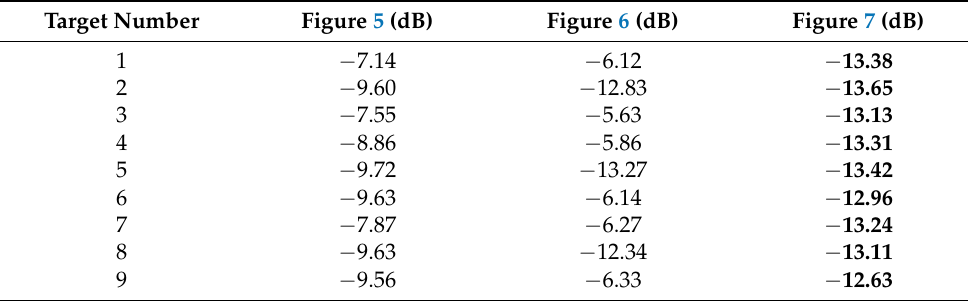
Table 3. The PSLR of the nine targets with different